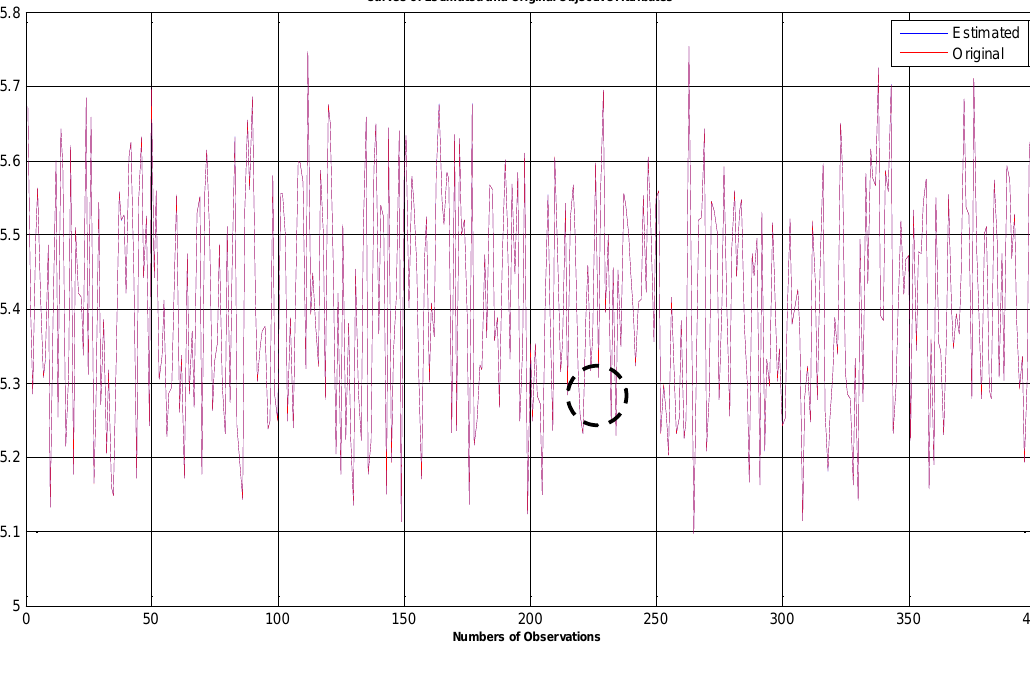
Figure 10. Zoom in the curve marked by a dotted circle in Figure